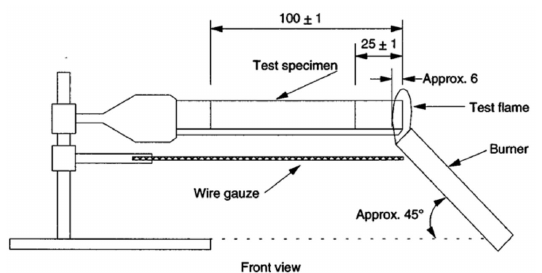
Figure 5. Burn test equipment according to ASTM